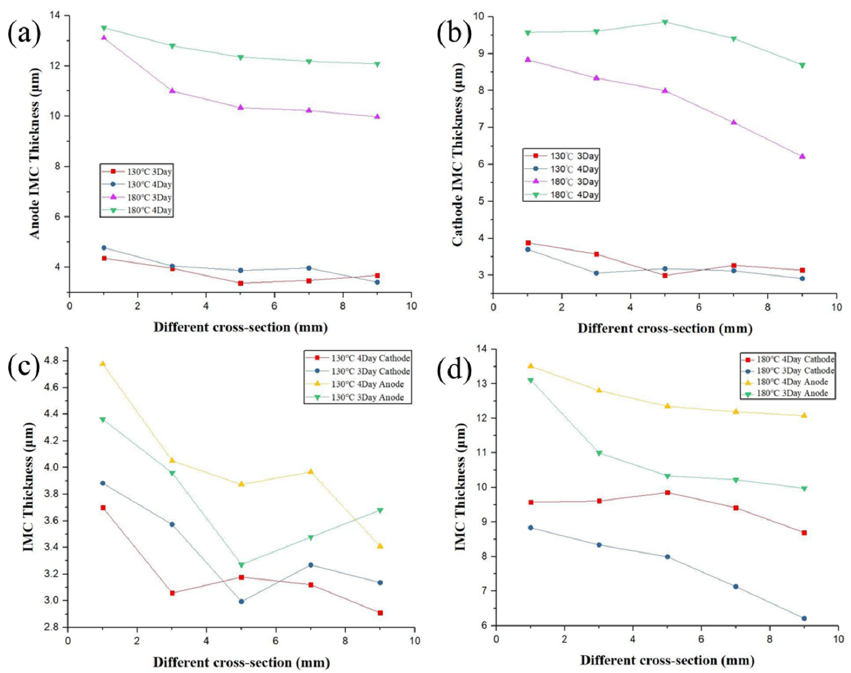
Figure 16. Analysis of the degree of IMC growth in the samples with di ff erent cross-sectional areas. ( a ) Anode end; ( b ) cathode end; ( c ) samples heated at 130 ◦ C; ( d ) samples heated at 180 ◦